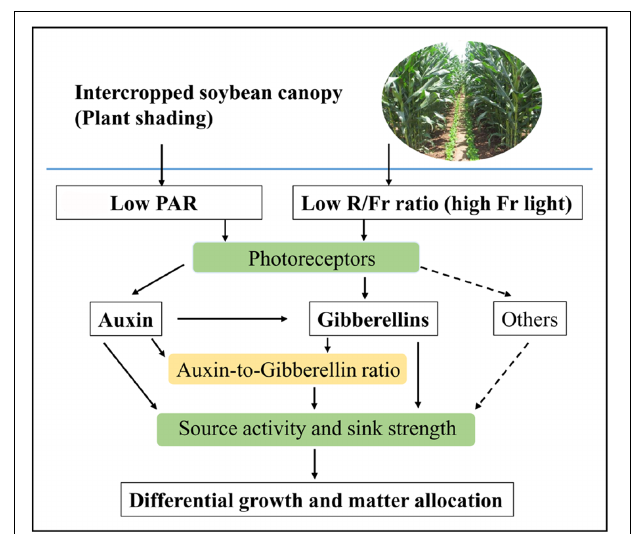
FIGURE 8 | Schematic representation of auxin (IAA), gibberellins (GAs), and IAA-to-GA ratio as signals for light intensity and quality in regulating soybean growth and matter partitioning. Arrows of solid line represent the regulating directions of light intensity and quality on soybean growth and matter allocation in this paper. Arrows of dotted line represent that light intensity and quality may affect differential growth and matter allocation by other hormones.